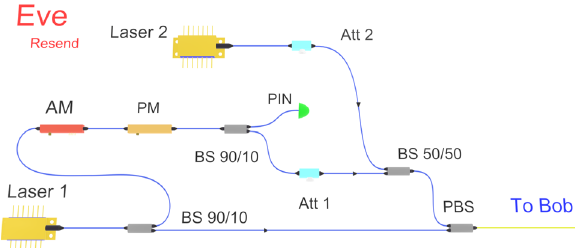
Figure 3. Setup for incoherent coherent attack strategy, relying on pulse injection from an external incoherent laser to induce saturation. AM: Amplitude Modulator, PM: phase Modulator, BS: BeamSplitter, PBS: Polarization BeamSplitter, Att: Variable Attenuator.